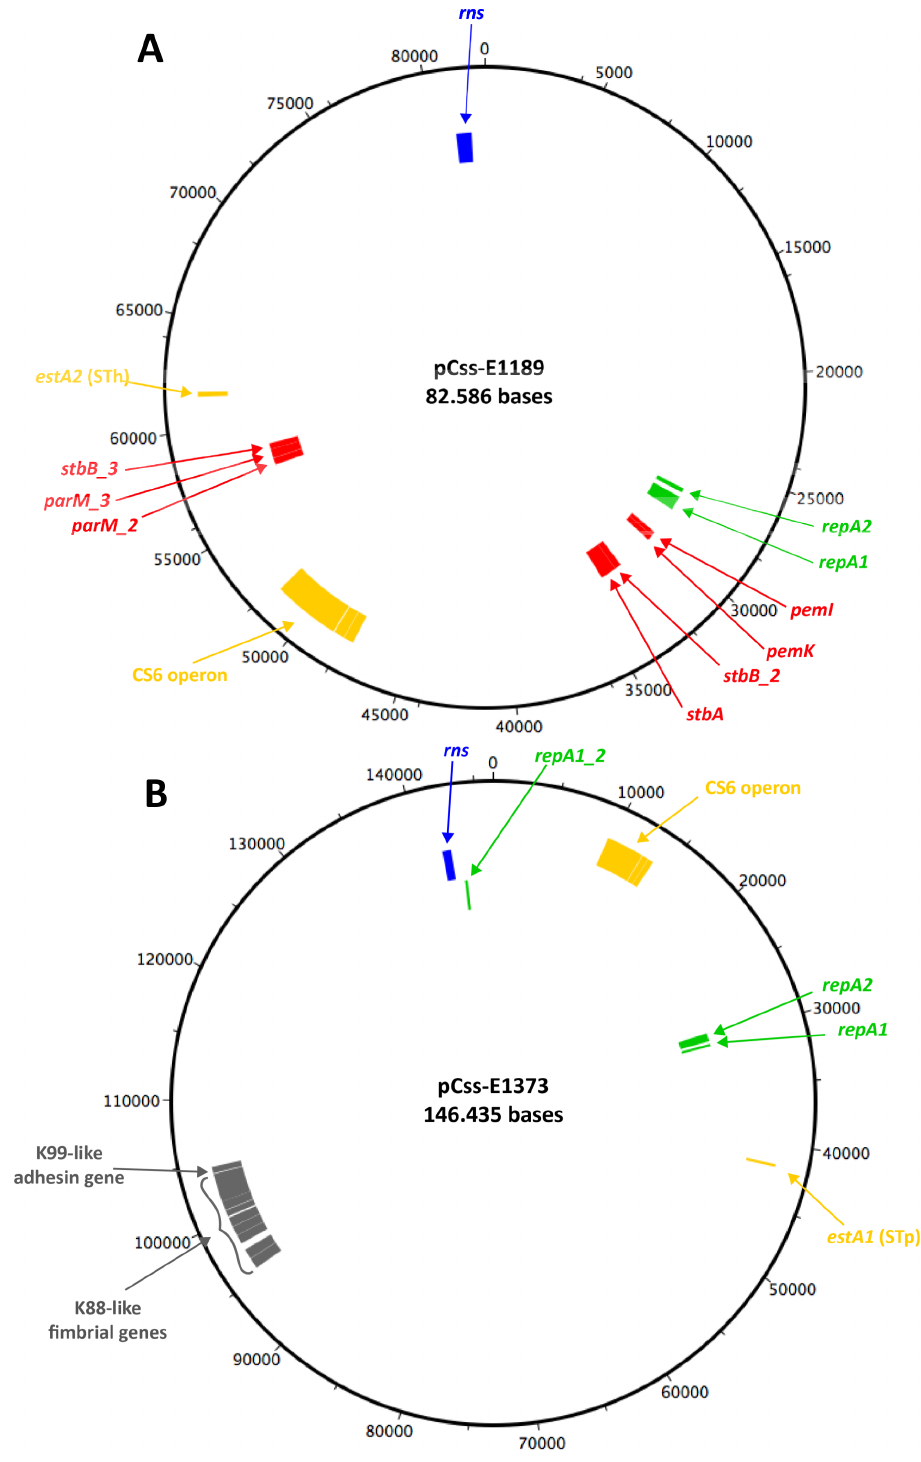
Fig 1. Graphical map of the plasmids pCss-E1189 (1A; Accession number LN908839), and pCss-E1373 (1B; Accession number LN908840). Virulence genes (in yellow), plasmid-specific genes for replication (in green) and for stability (in red), and the global regulator gene rns (in blue) are indicated. The plasmid-specific genes for stability found in pCss-E1189 were not found in plasmid pCss-E1373.